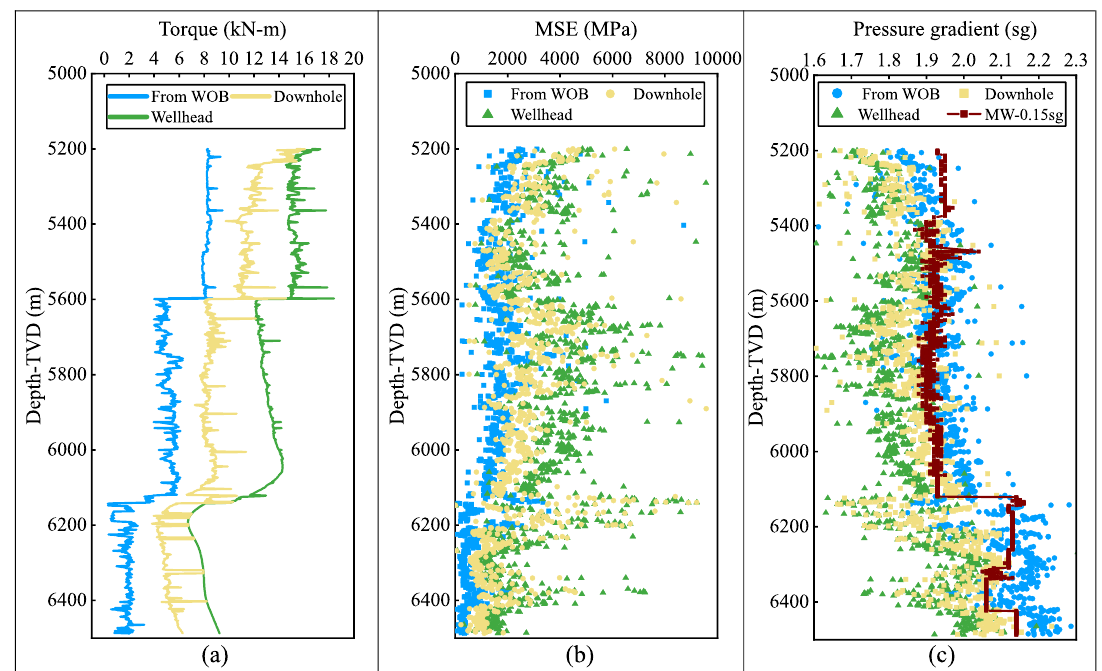
Figure 4. Comparison of detection results using torque from the wellhead, downhole and WOB for well M. ( a ) shows the torque from the wellhead, downhole and WOB; ( b ) plots the MSE computed from the different torque source; ( c ) presents the pore pressure detection values for the three cases.